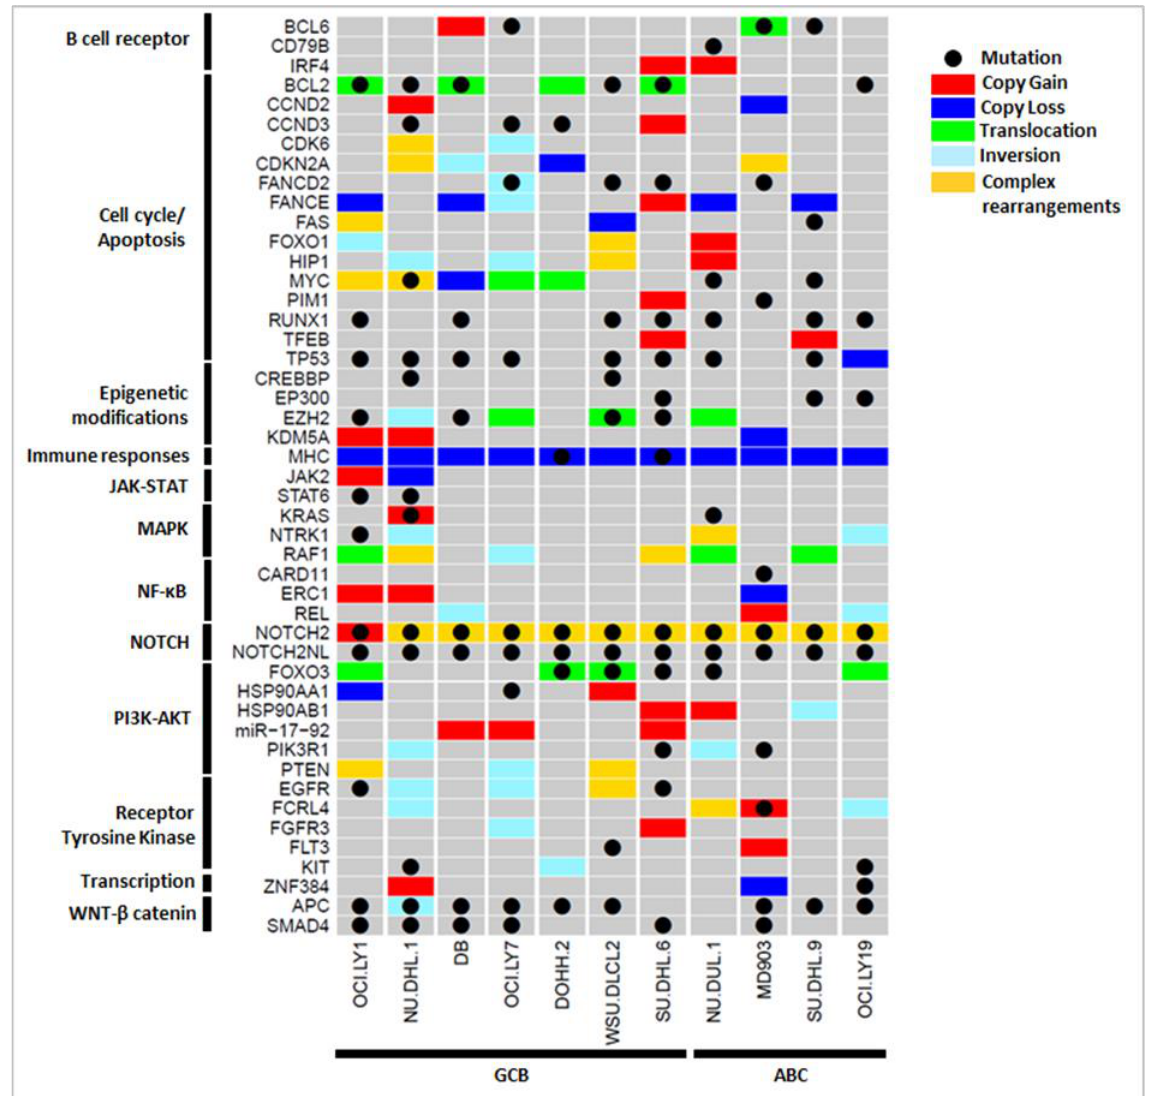
Figure 4. Integration of key SSVs (black dot), CNVs (gain: red, loss: blue), and SVs (translocation: green, inversion: cyan) revealed altered immuno-oncogenic pathways across 11 DLBCL cell lines. Complex genetic rearrangements with ≥2 SVs spanning the gene were also observed (gold yellow).